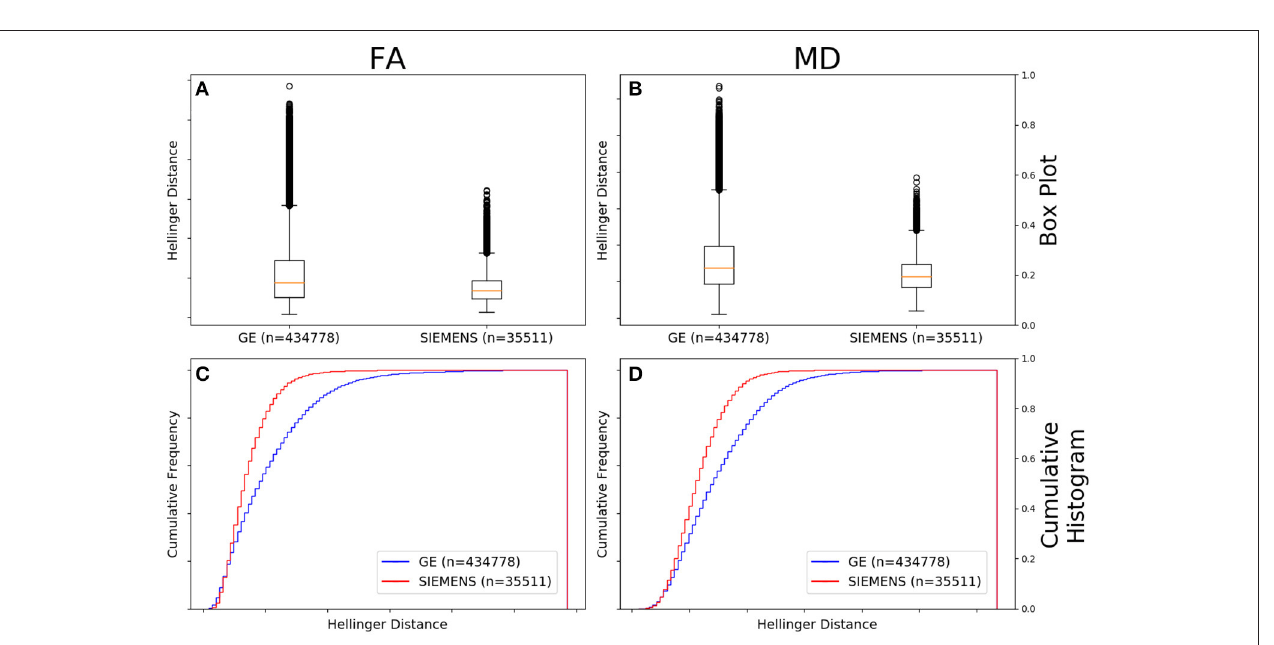
with a static field strength of 3.0T ( n = 13,861 comparisons) and Siemens data with a static field strength of 1.5T ( n = 10,011 comparisons) according to the Mann–Whitney U ( U = 6.0e7, p = 3e-77) and the Kolmogorov–Smirnov test (K–S = 0.1178, p = 1e-70) tests. The Hellinger distance between the median and